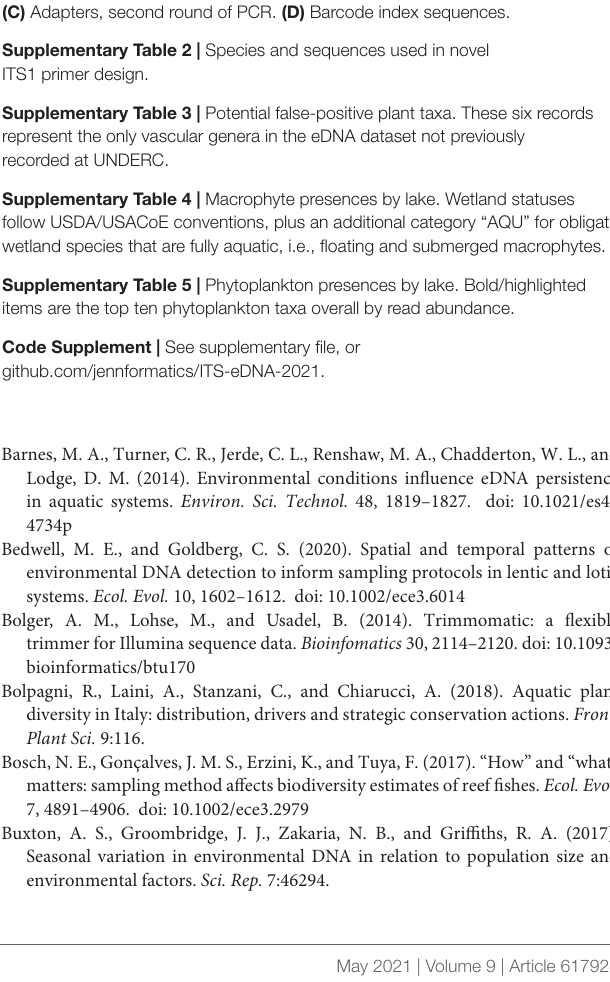
Supplementary Figure 1 | Details of OTU clustering and identification pipeline. Software versions of third-party software and descriptions of custom scripts for clustering and BLAST pipeline, including ambiguity resolution. Supplementary Figure 2 | Spearman correlations with diversity indices among lake covariates. The only factors that display substantial correlation across lake characteristics and biodiversity metrics are the area of the lake and the strength of its depth effect. However, the effect is not statistically significant ( P = 0.195), nor are any other correlations across lake characteristics and diversity metrics. Supplementary Figure 3 | Rarefaction and species accumulation curves. (A) Rarefaction curves by read number and per lake. (B) Species accumulation curve by sample over entire study.